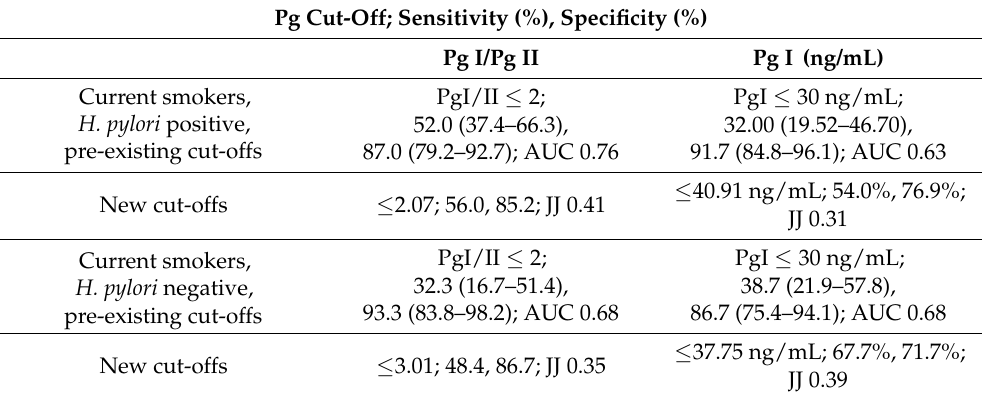
Table 6. Sensitivity and specificity of pre-existing and new pepsinogen cut-off values for current smokers by H. pylori